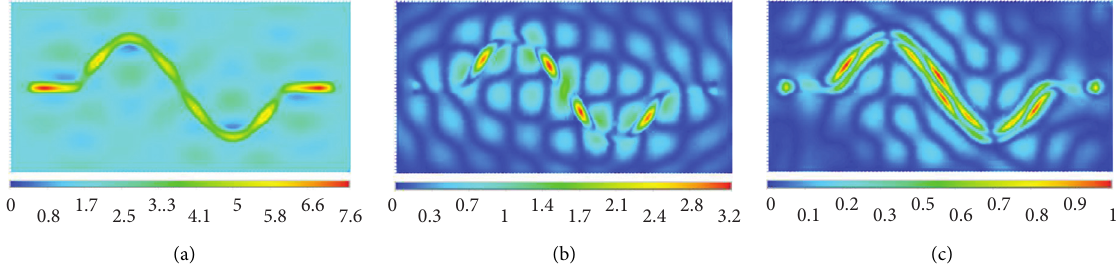
Figure 44: SV wave incident ( C